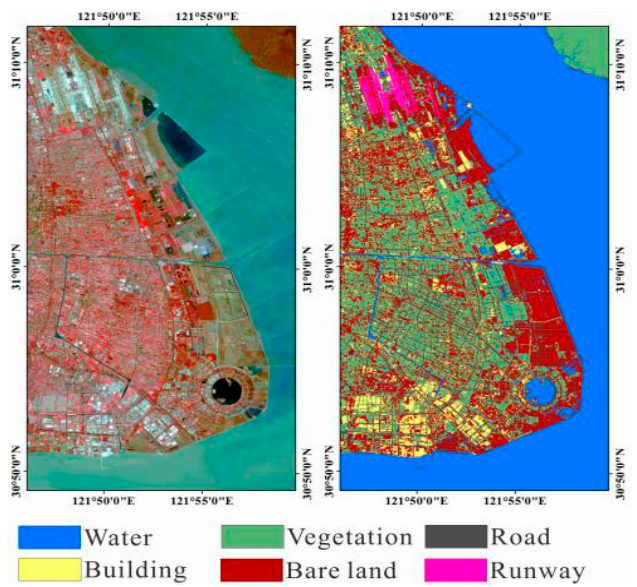
Figure 4. The left image shows the standard false color image of the reclamation area (the acquisition date is 28 February 2017). The red channel is the 8th band. The green channel is the 4th band. The blue channel is the 3rd band. The spatial resolution is 10 m × 10 m. The right image is the map of the land cover type in reclamation area (the spatial resolution is 10 m × 10 m).